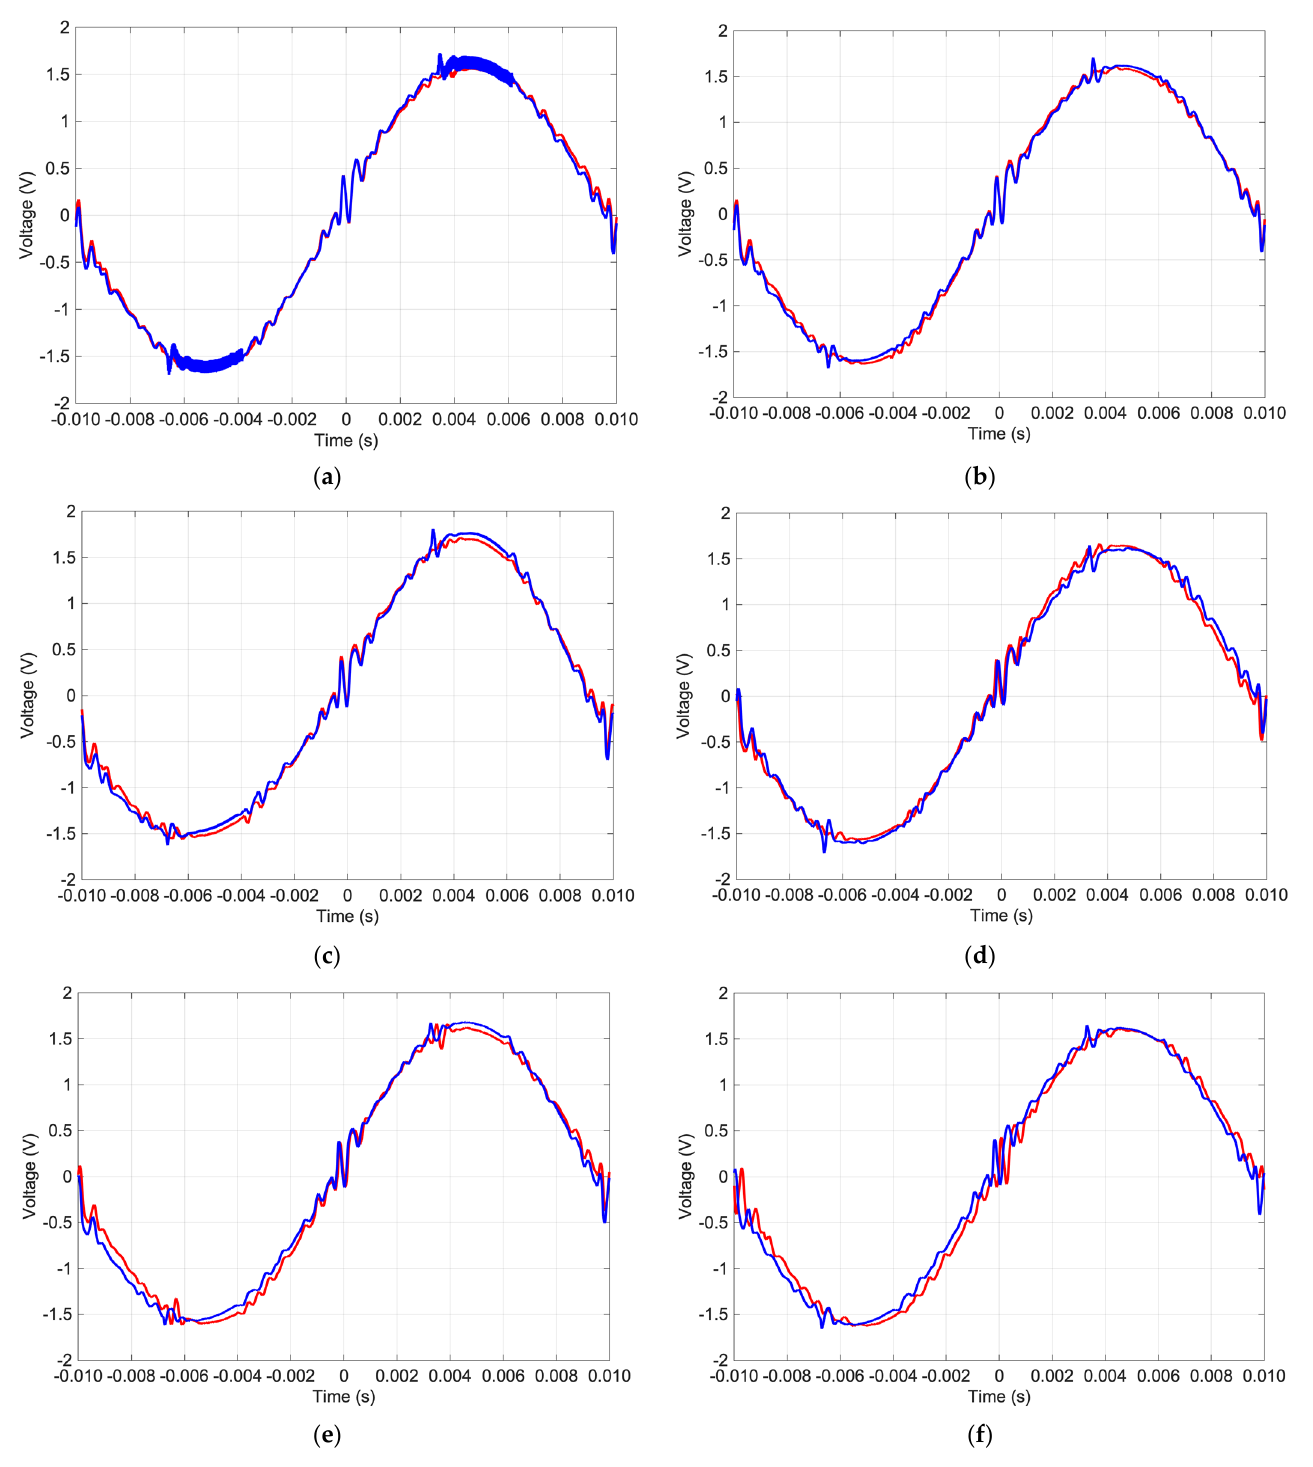
Figure 4. Time-domain waveforms for 25% (red) and 90% (blue) of the load with the 50 Hz fundamental artificially scaled for display purposes: ( a ) LW, ( b ) LB, ( c ) KT, ( d ) SH, ( e ) BA and ( f ) KA.